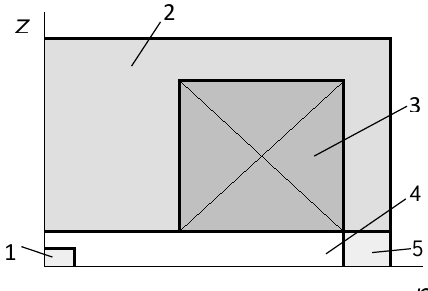
Table 4. Physical properties of components of the model.